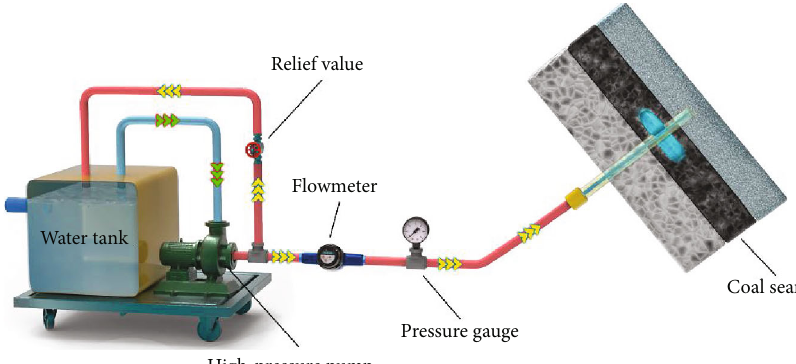
Figure 1: The schematic diagram of the high-pressure water jet system in the coal